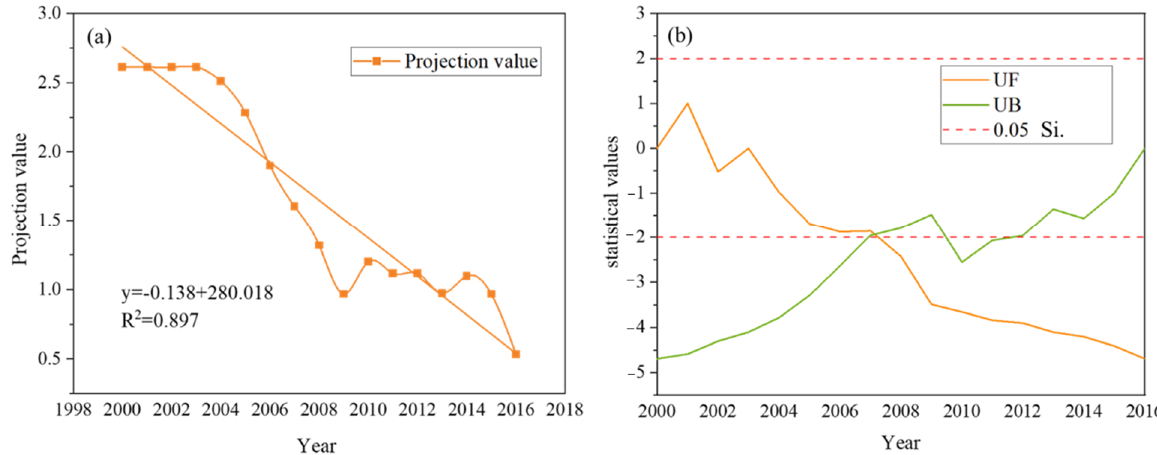
Figure 8. Analysis of mutation points of projection values in the period 2000–2016. ( a ) Projection value trend analysis. ( b ) Detection of abrupt change of projection value.